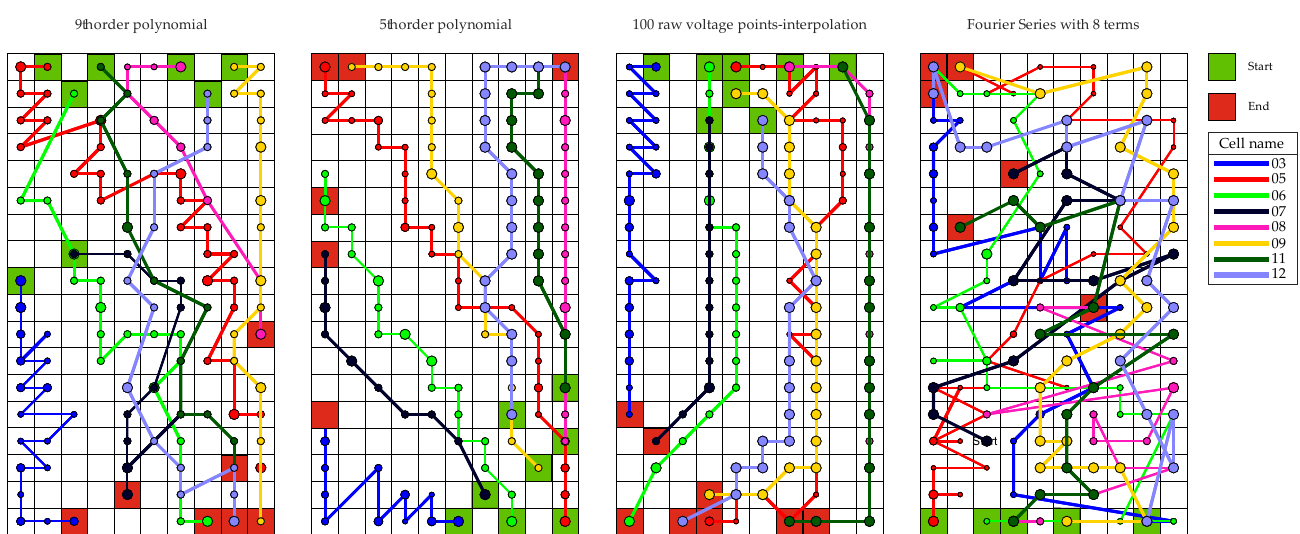
Figure 10. Four 10 × 18 maps trained by using four feature extraction techniques (9th order polynomial, 5th order polynomial, 100 voltage points, Fourier series with 8 terms); eight battery cell trajectories are displayed. Table 3. Metrics for 10 × 18 SOMs trained with input data obtained by using different feature extraction techniques. Input Features